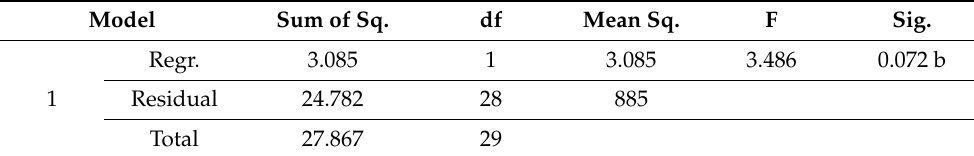
Table 2. E-court information quality and e-court ese. Model